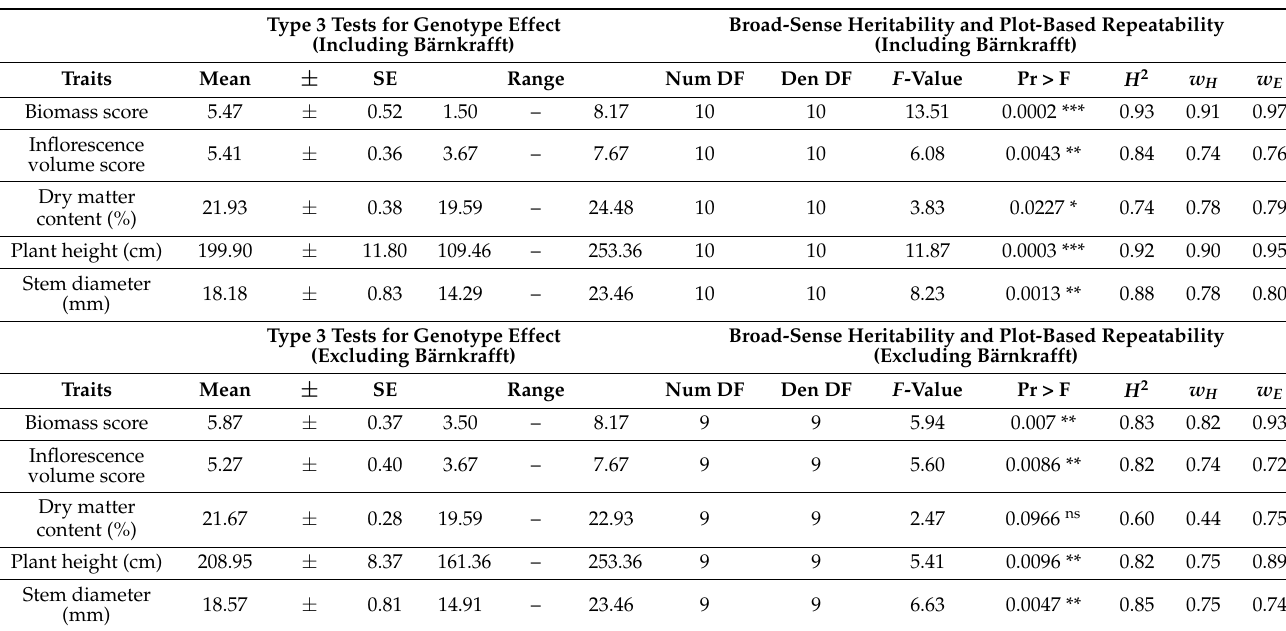
Table 1. Trait means, associated standard errors and ranges based on adjusted genotype means, mixed model analyses (Type 3 tests of fixed effects) with biomass yield components as dependent variables and genotype as fixed effect, and broad-sense heritability and plot-based repeatability values estimated in Heidfeldhof and Eckartsweier, including and excluding